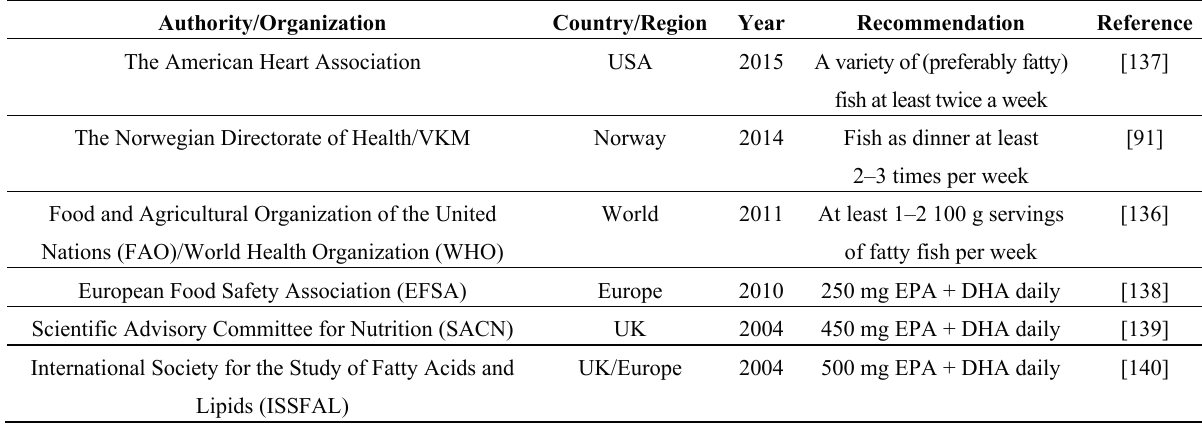
Table 3. Overview of dietary recommendations regarding fish or marine n -3 fatty